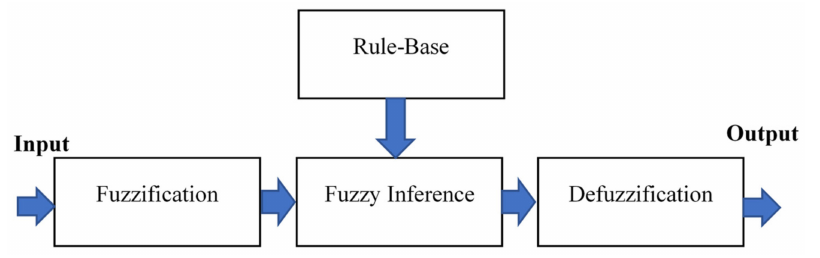
Figure 1. Fuzzy logic classification